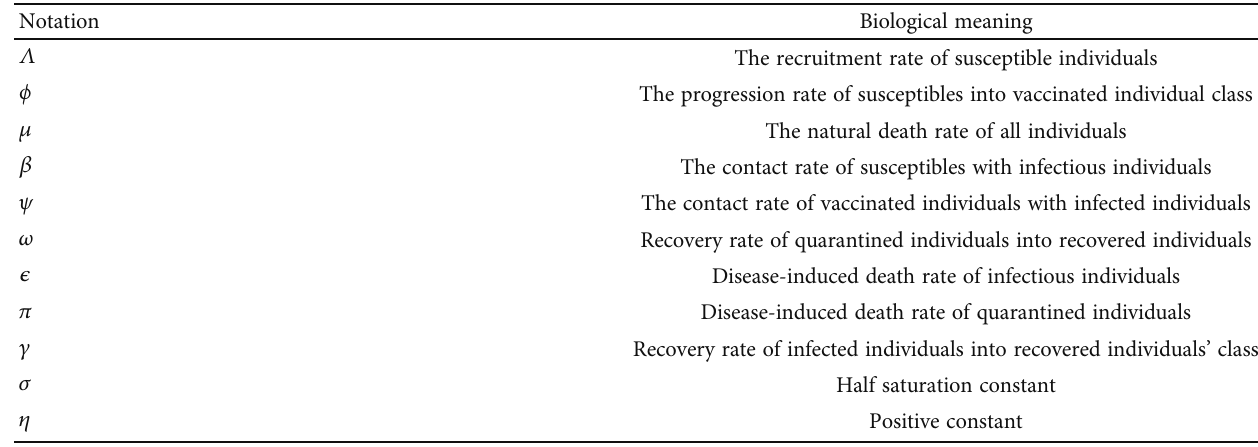
Table 1: Description of model parameters.